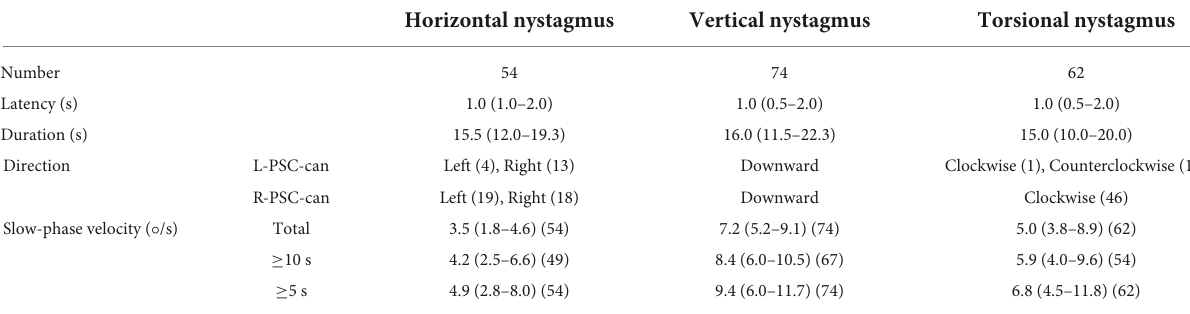
for the head-hanging position and the sitting position were close